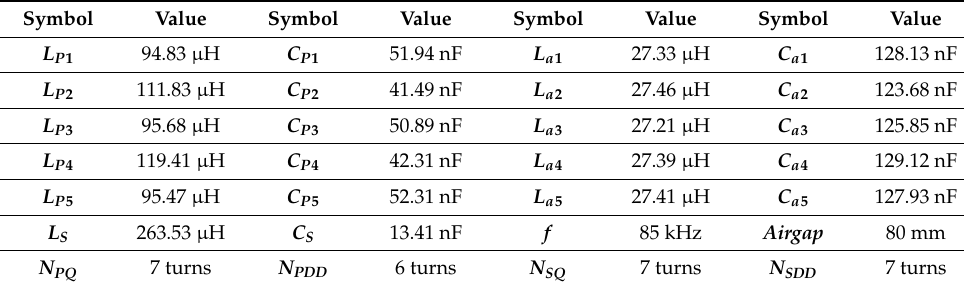
Figure 13. The diagram of the ultrasonic detection part. Table 2. Measured parameters from the experimental